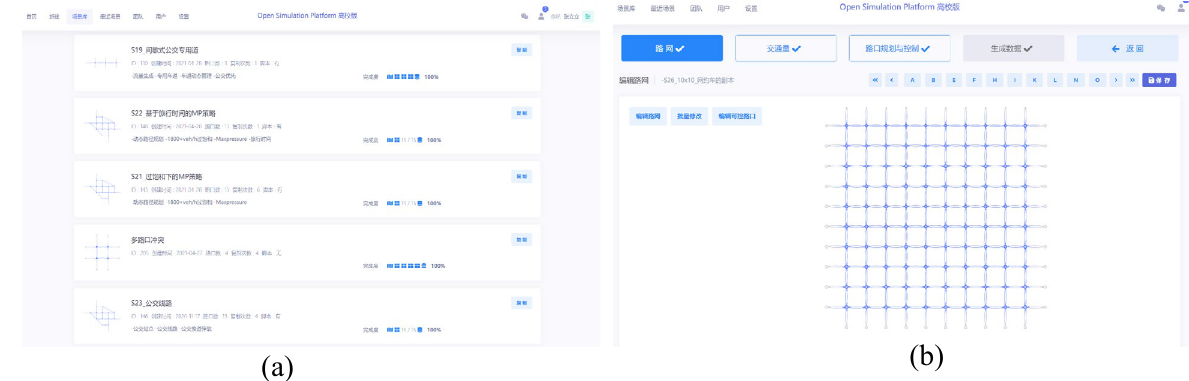
Figure 3. Online simulation module. ( a ) Simulation scene library, ( b ) Simulation parameter